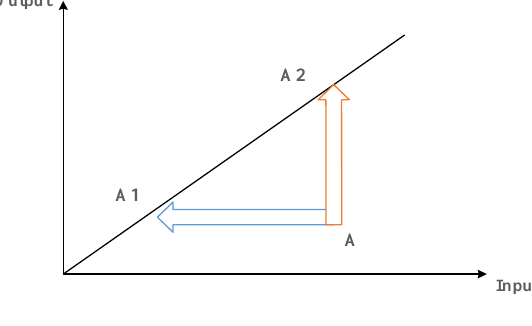
Figure 2. Performance improvement